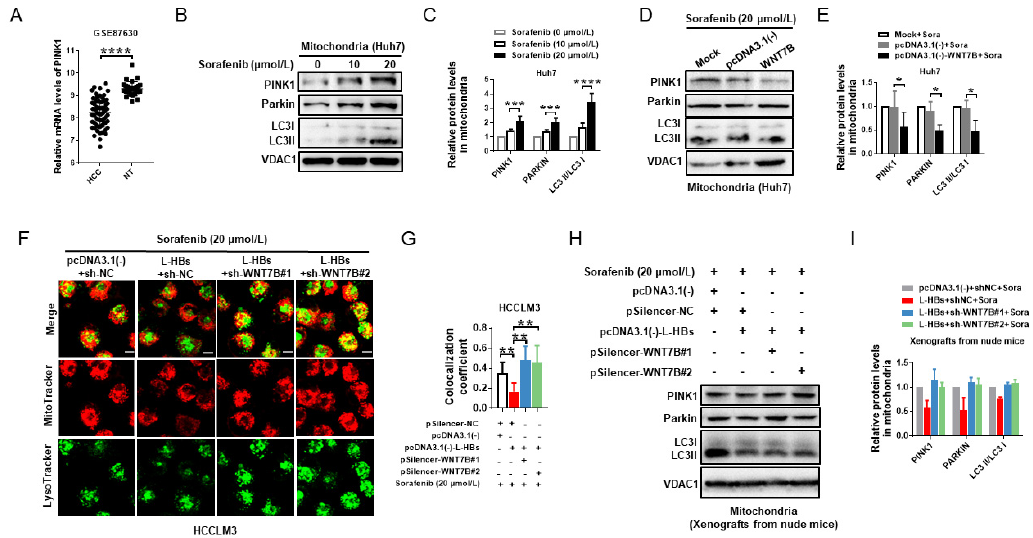
Figure 6. Large hepatitis B surface antigens (L-HBs) inhibit sorafenib-induced mitophagy via WNT7B in HCC. ( A ) PINK1 expression in HBV-related HCC and nontumor liver tissues were analyzed in GSE87630. ( B , D , H ) Examination of mitochondria proteins by Western blotting. ( C , E , I ) The expression of PINK1, PARKIN, LC3I, and LC3II was quantified and represented as mean ± SD. ( F ) Representative fluorescent images of MitoTracker, LysoTracker, and MitoTracker/LysoTracker colocalization using laser confocal scanning microscopy (Scale bar, 50 μ m). ( G ) Quantitative analysis of MitoTracker/LysoTracker colocalization coefficient. * p < 0.05, ** p < 0.005, *** p < 0.001, **** p <